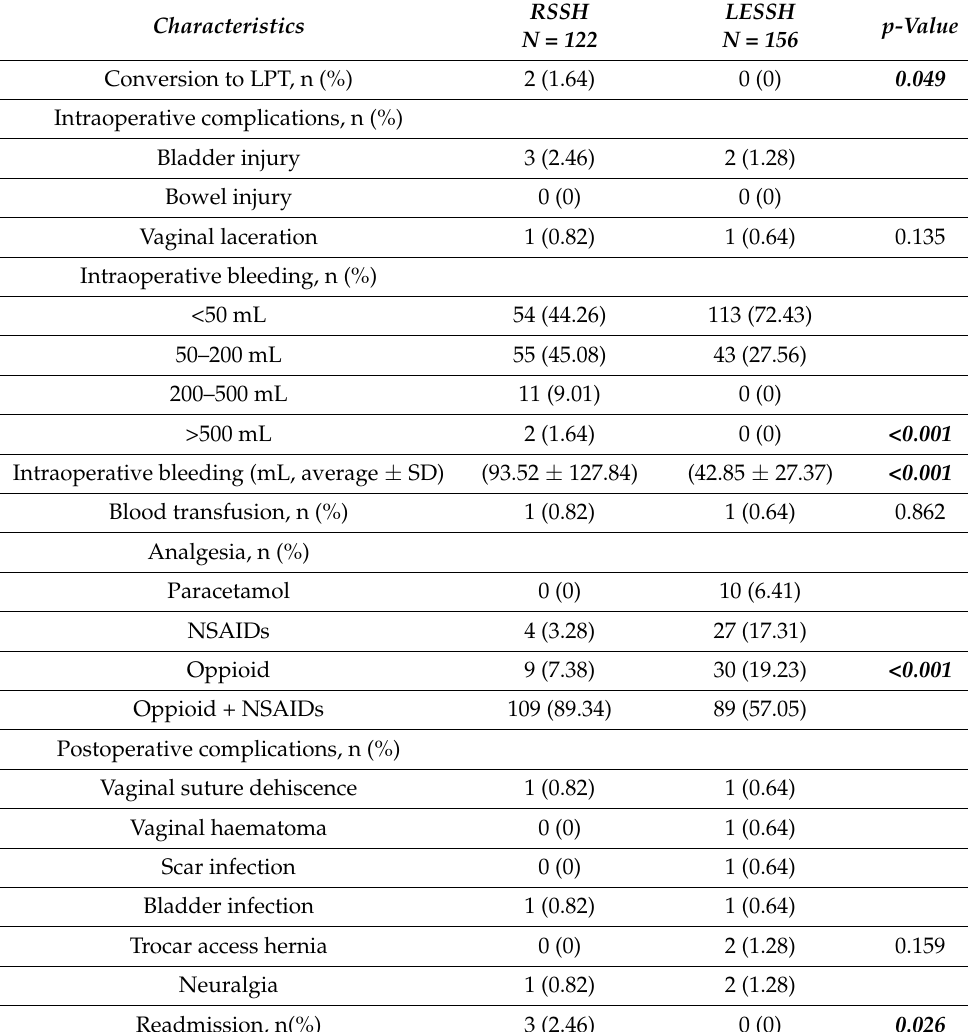
Table 3. Surgical outcomes in RSSH and LESSH